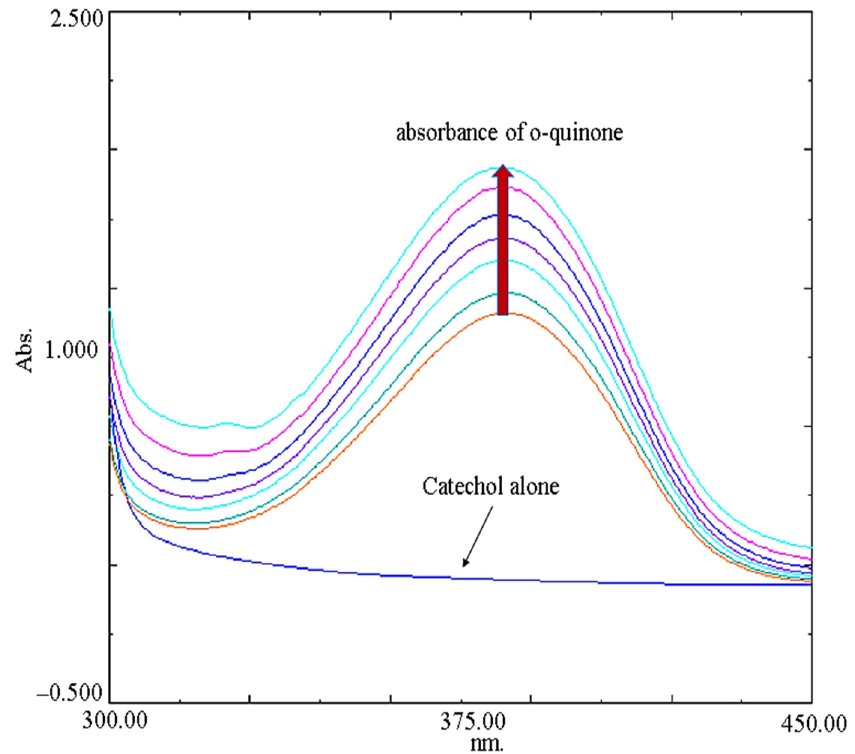
Figure 5. UV-visible spectra of absorbance of o-quinone from the oxidation of catechol in the presence Figure 5. UV ‐ visible spectra of absorbance of o ‐ quinone from the oxidation of catechol in the pres ‐ ence of the [(Cl) 2 Mn(RCOOET)] in THF. of the [(Cl) 2 Mn(RCOOET)] in THF.